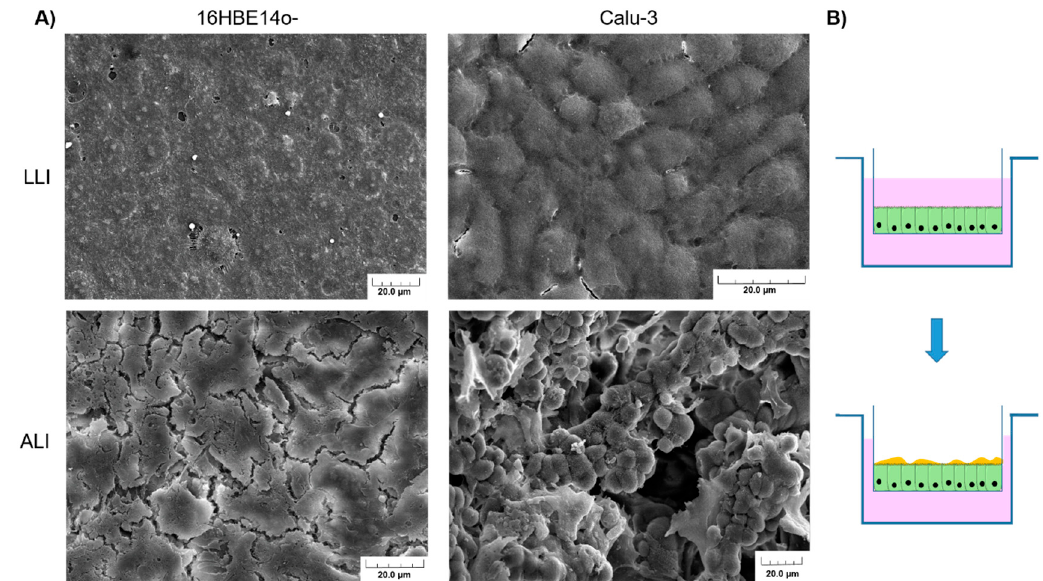
Figure 4. (A) Scanning electron microscopy of 16HBE41o- and Calu-3 cultivated in the liquid–liquid interphase (LLI) or air–liquid interphase (ALI) for 3 weeks after seeding. When cultivated under ALI conditions, unlike 16HBE41o-, Calu-3 cells produce mucus and form microvilli. For all pictures, the scale bar corresponds to 20.0 µm. (B) Transition from LLI culture to ALI allowing cell differentiation and in some case, depending on the cell line, mucus production.